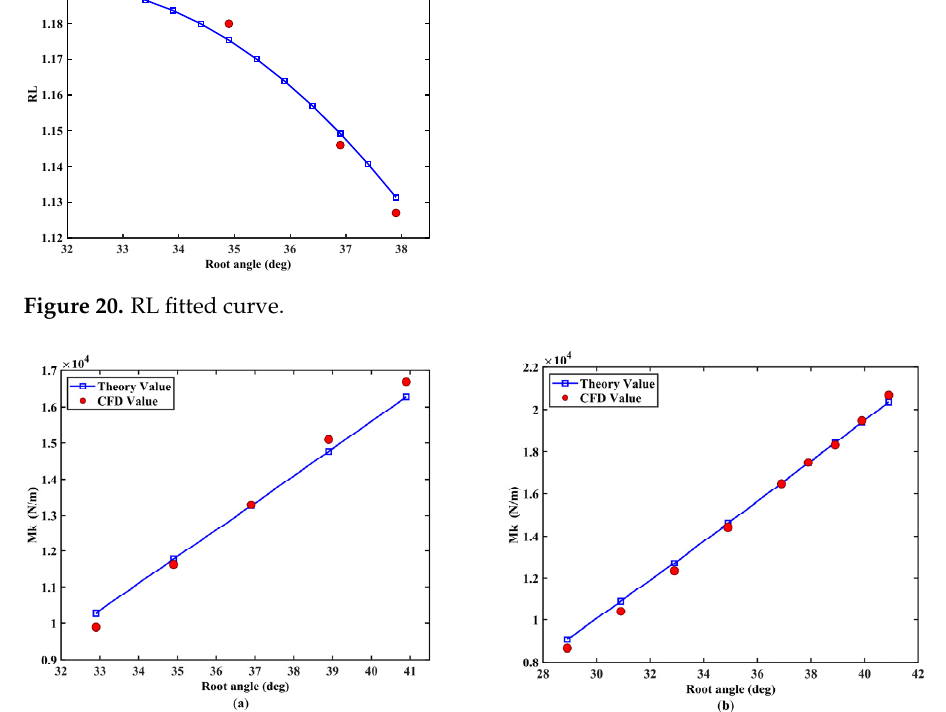
Figure 21. Hovering Mk calculation at sea level. ( a ) 58 rad/s database. ( b ) 65 rad/s database.